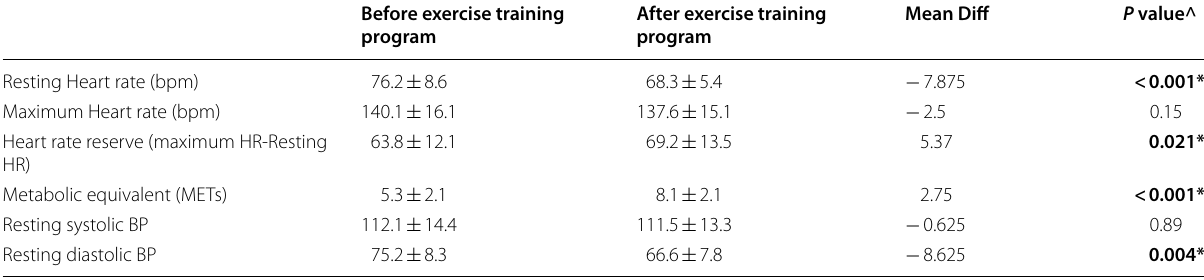
Table 3 Heart rate (resting, maximum and reserve), METs, resting blood pressures (systolic and diastolic) of the TG before and after the training